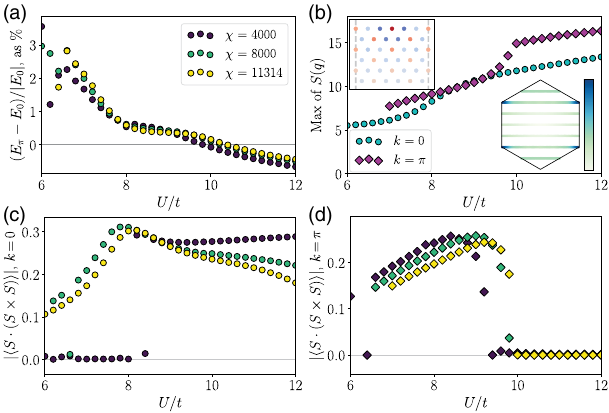
FIG. 7. Results for the YC6 cylinder. (a) Relative energy (percent difference) between ground states in the symmetry sectors with k ¼ π and k ¼ 0 around each ring. (b) Maximum value of the spin structure factor for the two momentum sectors. The insets show (lower right) the high- U spin structure factor for the k ¼ π sector, with peaks at the K (cid:3) points as expected for 120° magnetic ordering, and (upper left) the corresponding real-space h S · S i correlations to a chosen point (center on the top). (c) Chiral order parameter for the k ¼ 0 ground state. (d) Chiral order parameter for the k ¼ π ground